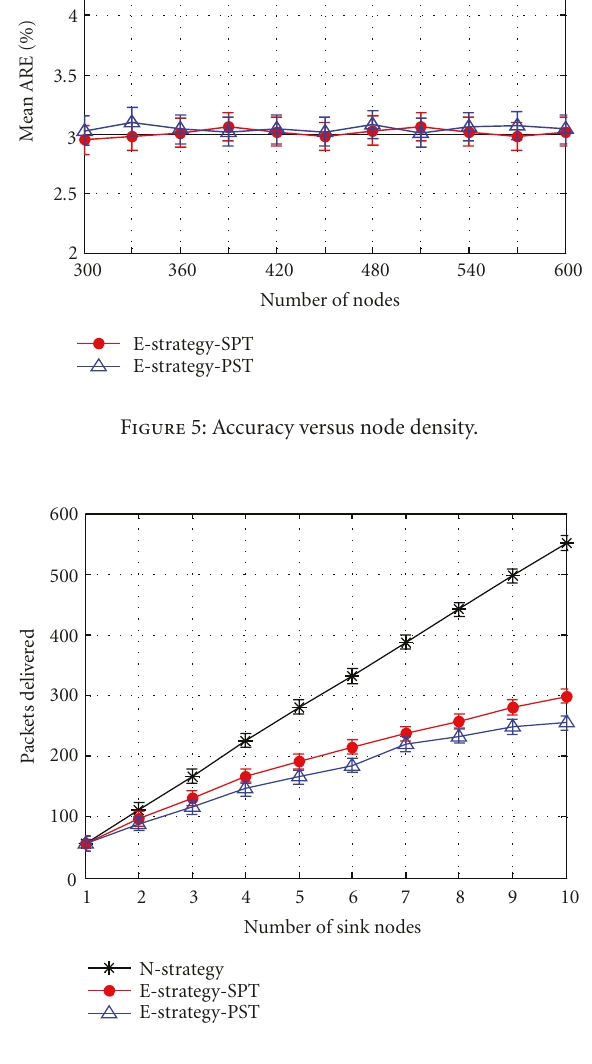
Figure 6: Cost versus number of sink nodes.